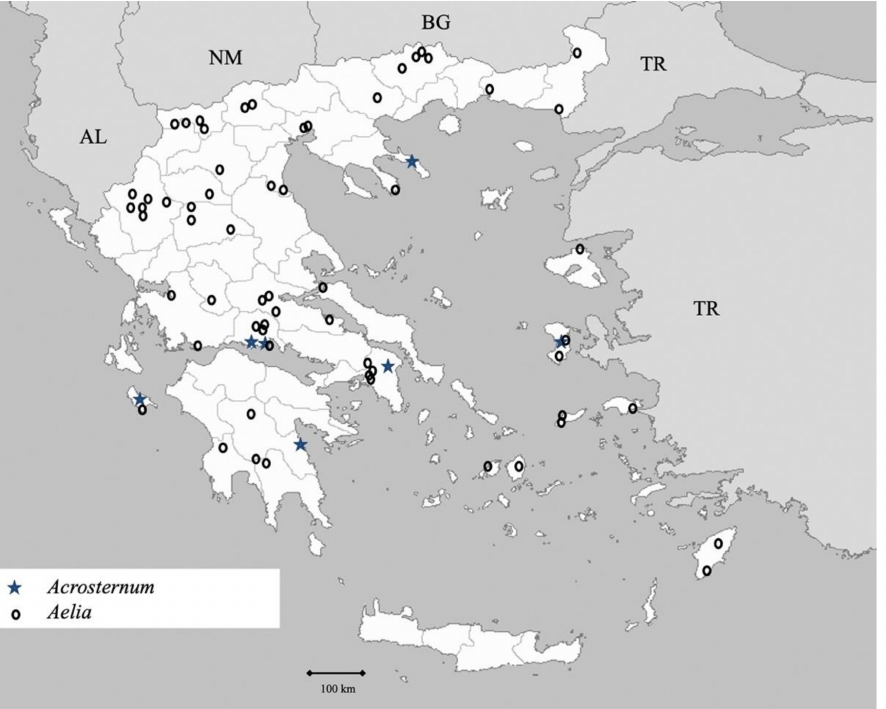
Figure 6. Map showing collecting sites of species of genera Acrosternum and Aelia during the present study in Greece.